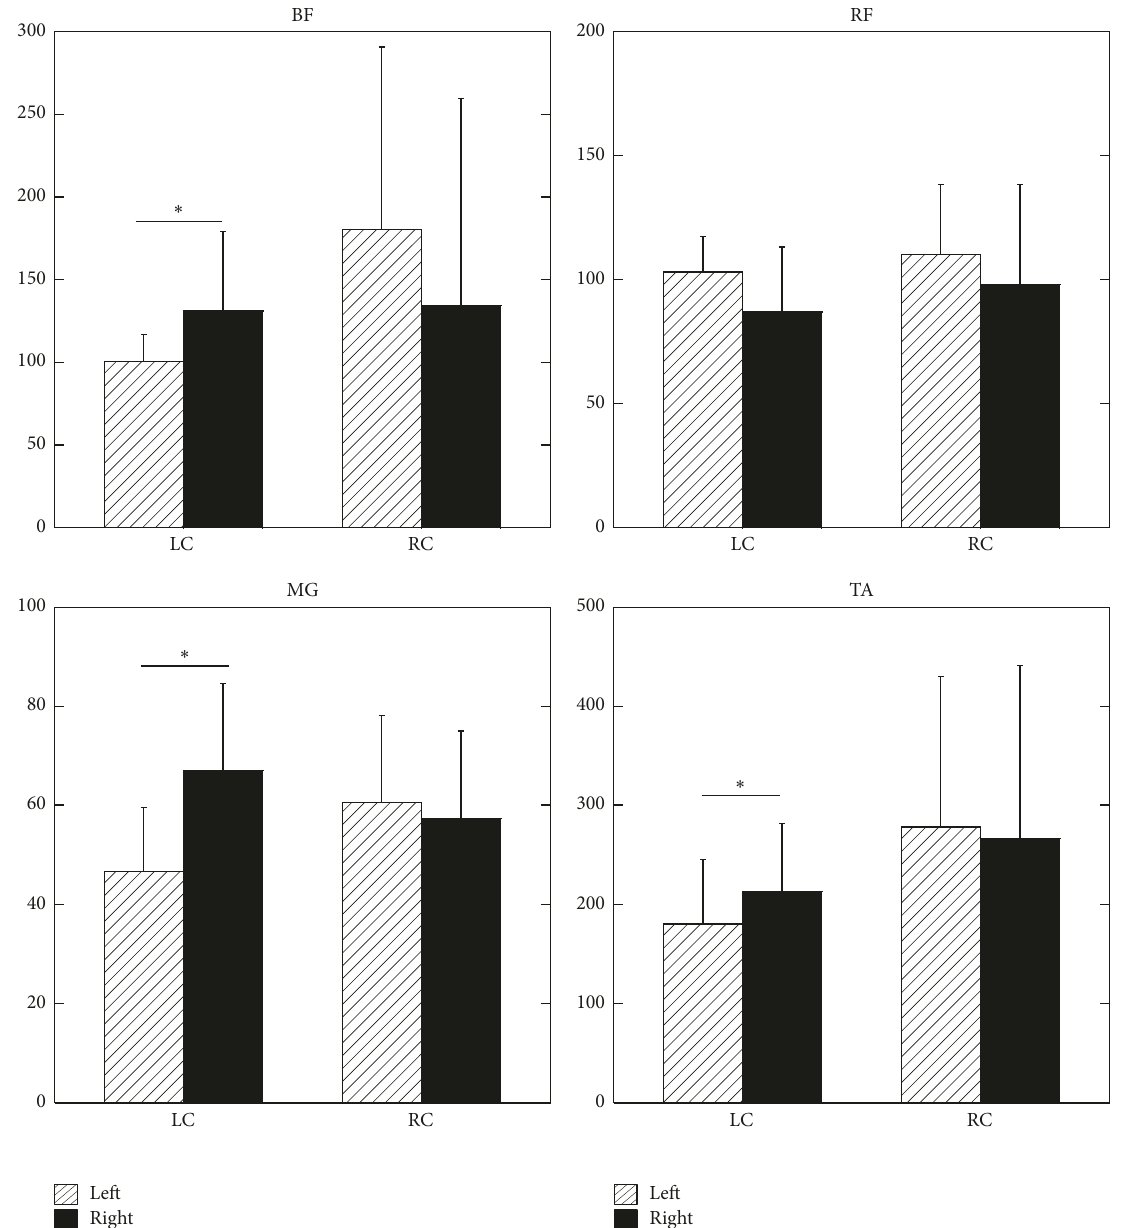
Figure 2: Integrals of EMG activity of the left and right muscles (mV ∗ s). Note increased EMG activity in the muscles on the side contralateral tothesideoftheinduceddiscomfort.LC:discomfortinducedontheleftside,RC:discomfortinducedontherightside.L:left,R:right. ∗ shows statistical significance (𝑝 < 0.05)